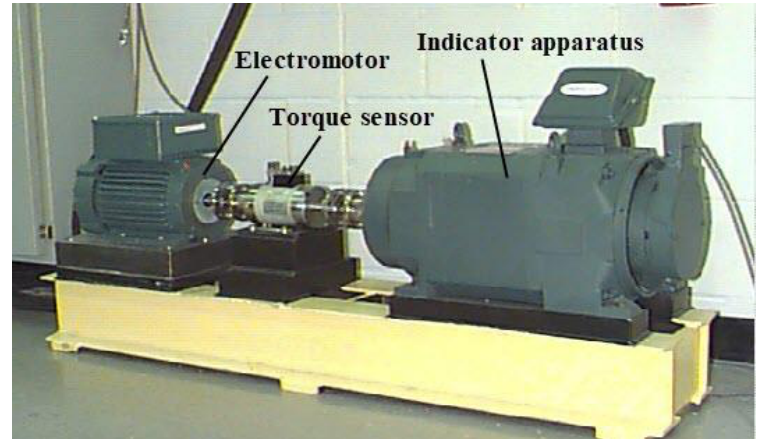
Figure 7. Simulation experimental platform for rolling bearing faults. Table 5. Classification of the bearing fault datasets.